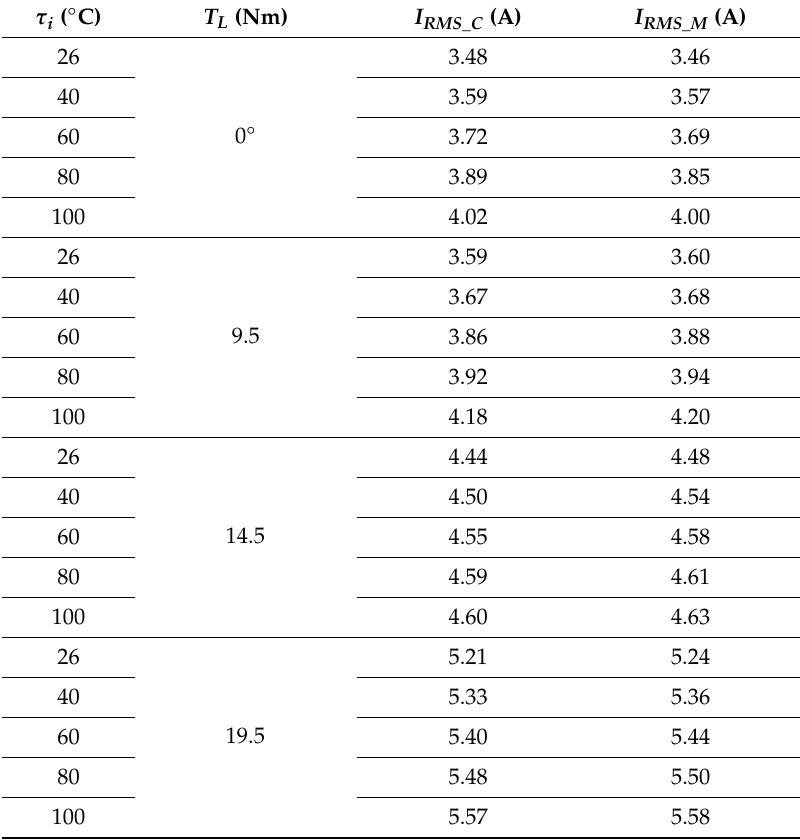
Figure 10. Time curves of ( a ) phase currents and ( b ) rotor speed in τ i = 100°C for T L = 19.5 Nm, J i = 0.0082 kgm 2 . Table 3. Influence of temperature and load torque on RMS of motor current.